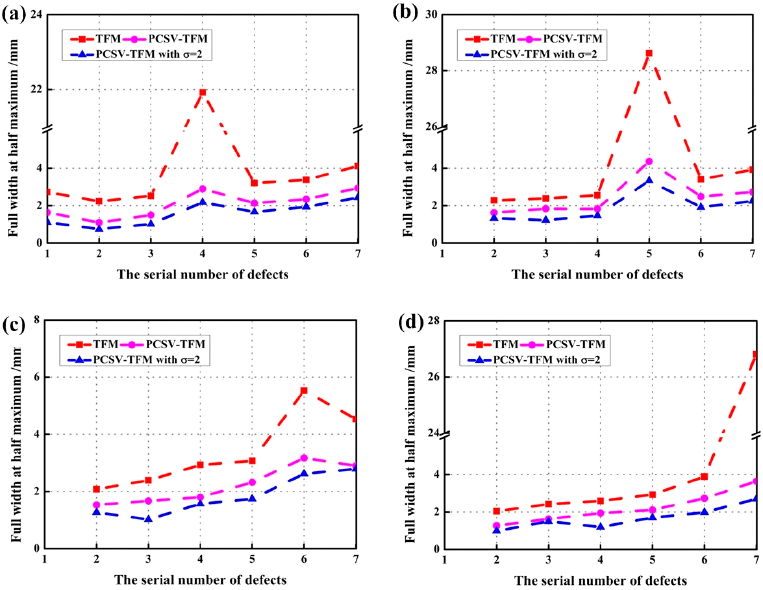
Figure 10. The full width at half maximum at the depth of ( a ) the fourth defect covered; ( b ) the fifth defect covered; ( c ) the sixth defect covered; ( d ) the seventh defect covered; by using TFM, PCSV-TFM, and PCSV-TFM with power exponent σ = 2.